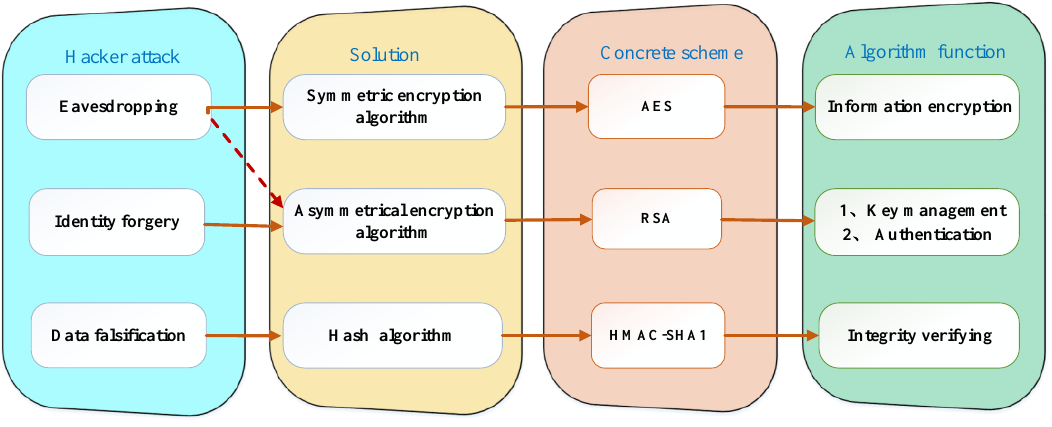
Figure 5. Hybrid cipher algorithm.